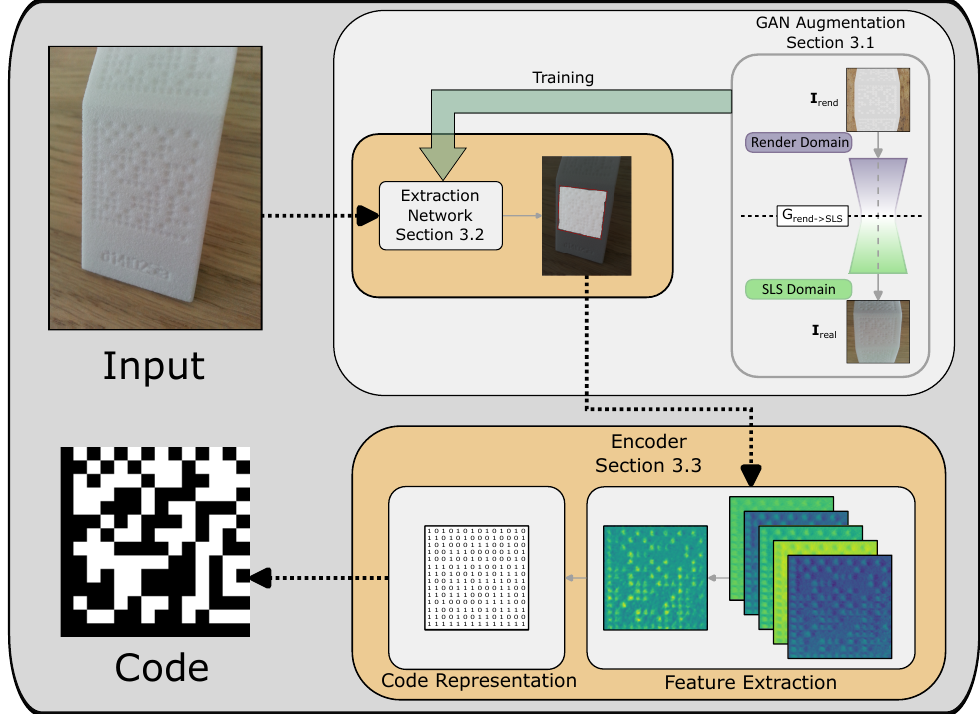
Figure 2. The approach’s steps for reading a data matrix code are presented. DPM areas are extracted (Section 3.2) and transformed into standard data matrix code (Section